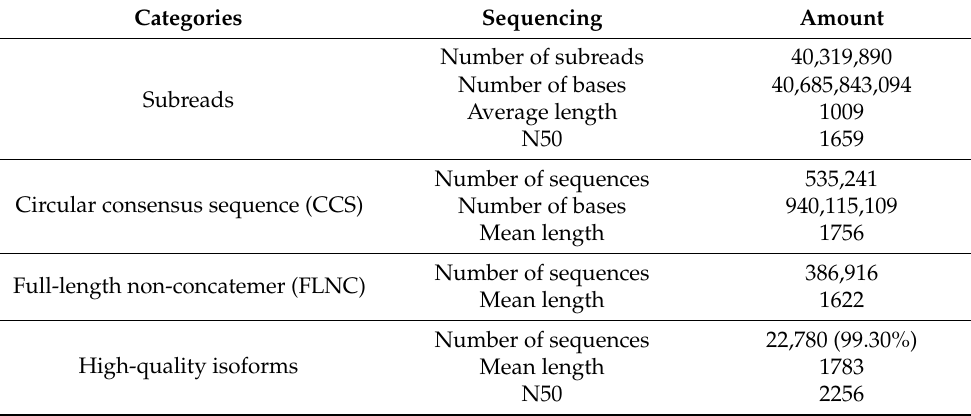
Table 2. Data filtering results of the B. dorsalis